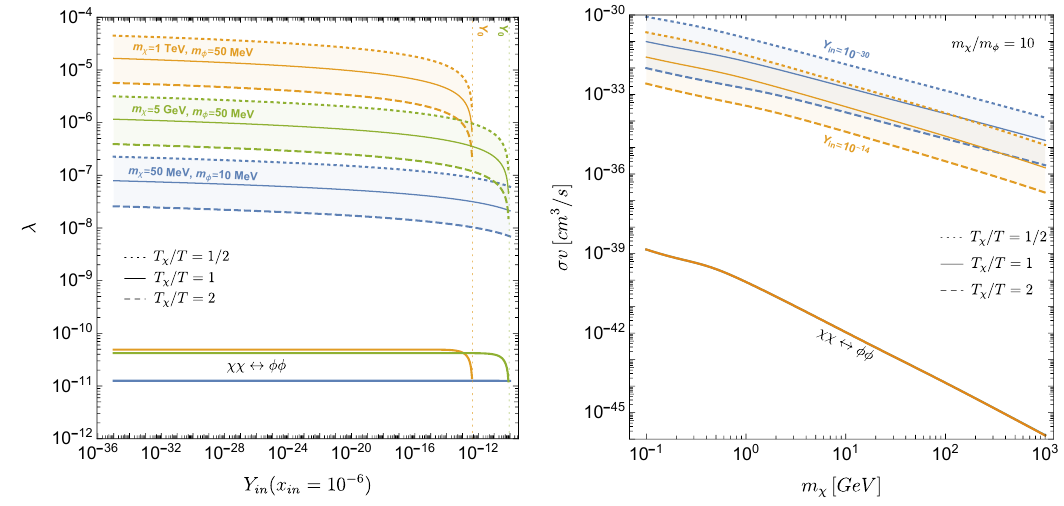
Figure 1 . The value of the coupling λ (left) and the present day annihilation cross section (right) giving Ω h 2 = Ω DM h 2 through the semi-production mechanism for different choices of masses and fixed T χ /T . The solid lines give the corresponding values if the process was φφ → χχ